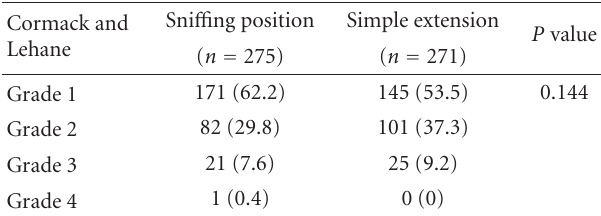
Table 2: Comparison of views obtained during